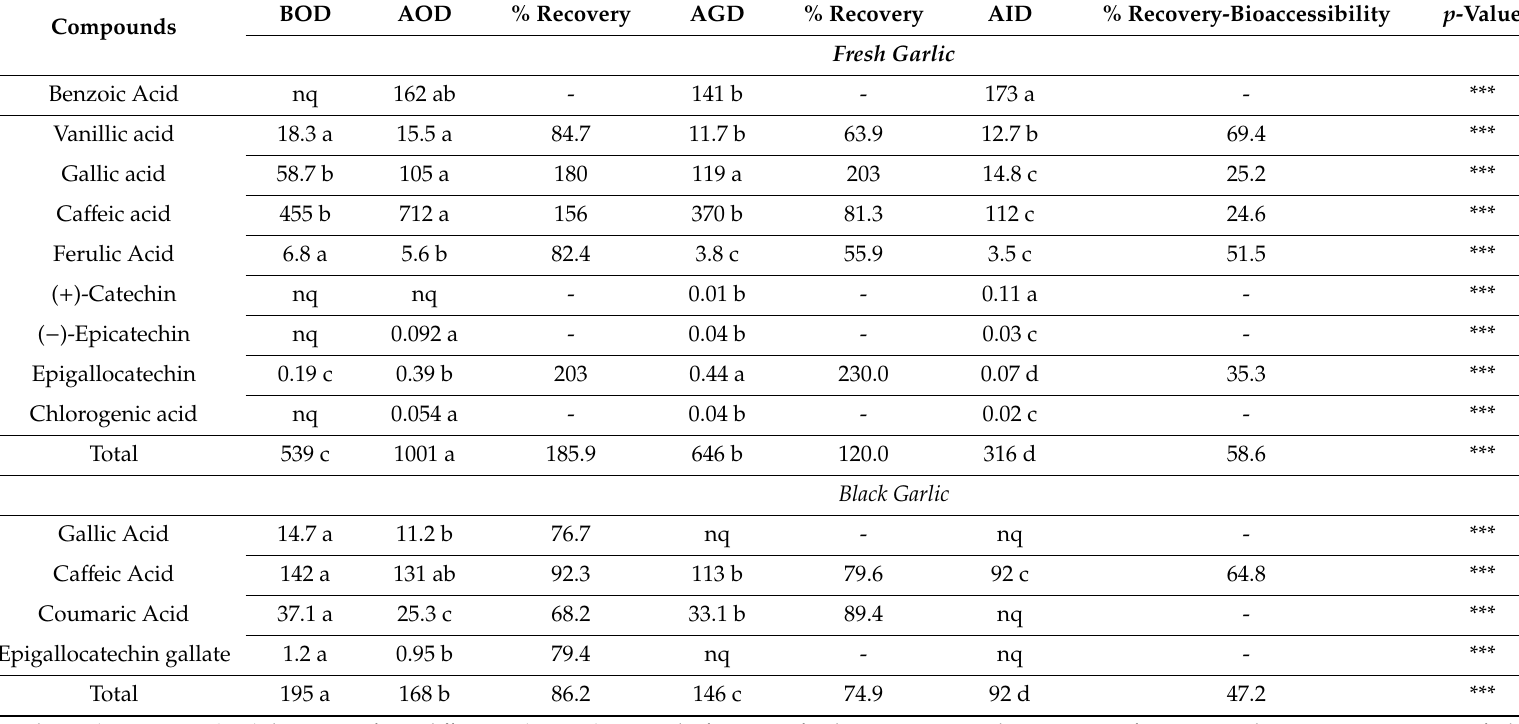
Table 1. Concentration (nmol / g FW) of (poly)phenols presented in fresh and black garlic samples at di ff erent stages during the simulated gastrointestinal digestion. Data are expressed as mean values ( n =